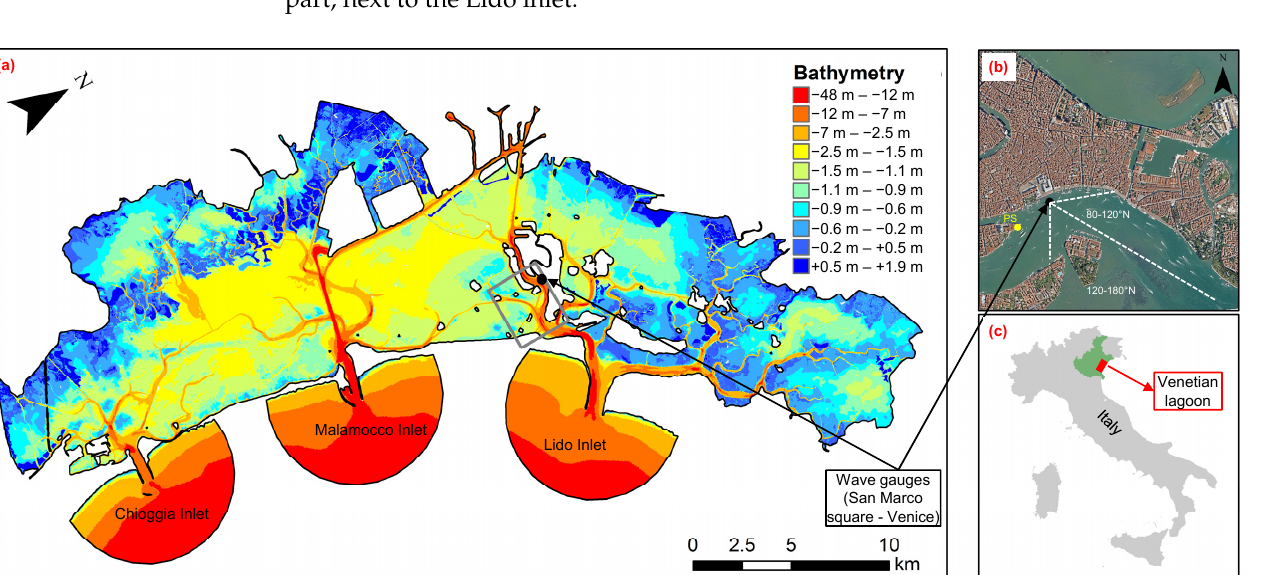
Figure 1. ( a ) Bathymetry of the Venetian lagoon where the three lagoon inlets and the position of the San Marco square are highlighted; the grey box indicated the nested grid domain used in the numerical modelling; ( b ) San Marco basin: the box also shows the Punta della Salute (PS) tidal gauge and two fetch sectors for wind-wave generation; ( c ) Italian peninsula and location of the Venetian